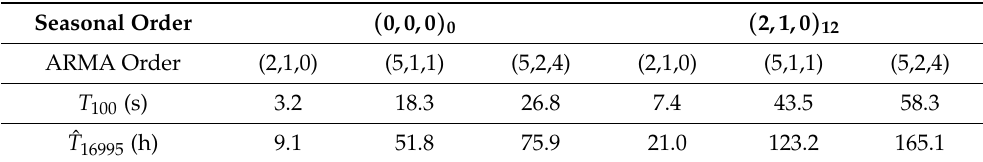
Table 1. The measured and estimated times for fitting the ARIMA models of given orders to ECG data